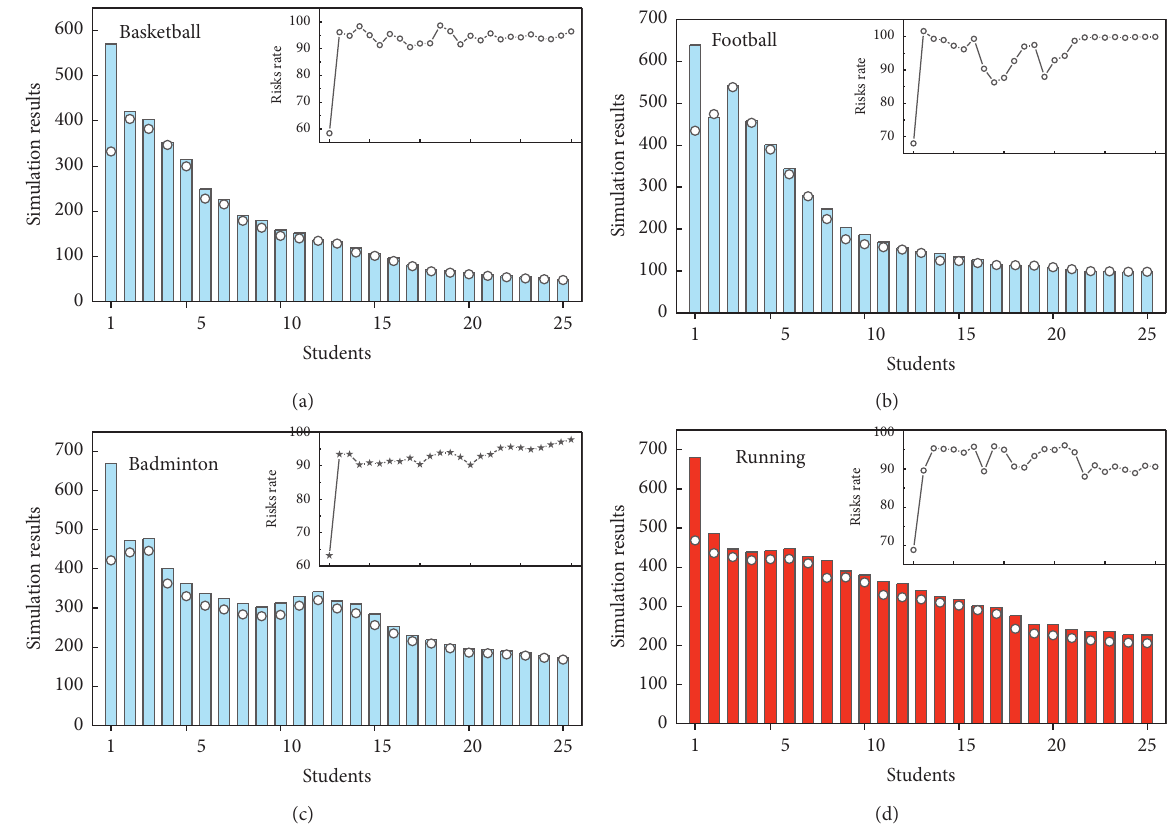
Figure 5: Decision tree predictions for basketball, soccer, badminton, and running performance.